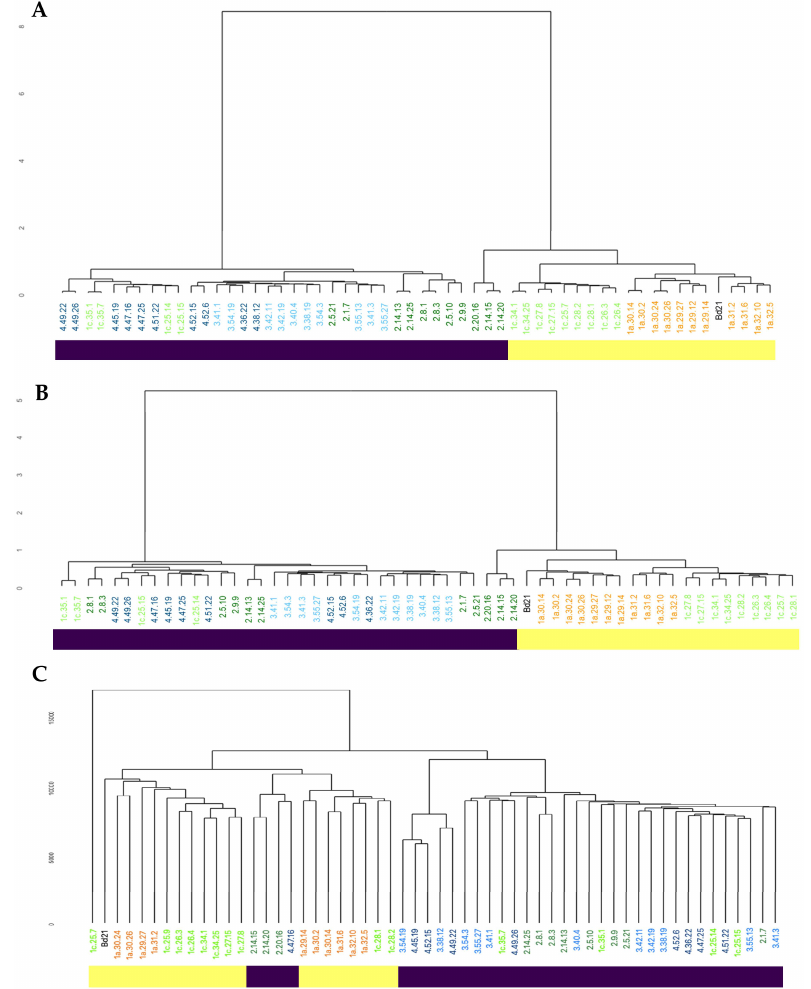
Figure 2. Hierarchical clustering analysis showing variation in whole genome ( A ) CpG, ( B ) CHG and ( C ) CHH methylation patterns based on the similarity of the accession’s methylation profiles. Accessions from particular regions are color-coded (1a—orange, 1c—light green, 2—dark green, 3—light blue, 4—dark blue). Bd21 (from Iraq) is indicated in black. The yellow and purple horizontal bars indicate accessions broadly classified as central and coastal subpopulations, respectively. Region 1c accessions (1c_25_14, 1c_25_15, 1c_35_1, 1c_35_7) with an Extremely Delayed Flowering (EDF + ) [10] genotype are also located with the coastal subpopulation clade and are given that classification. Although classified as part of the coastal subpopulation the S + genotype accessions 2_14_15, 2_14_20, 2_20_16, were found in distinct clades in each methylation context; especially in CHH ( C ).